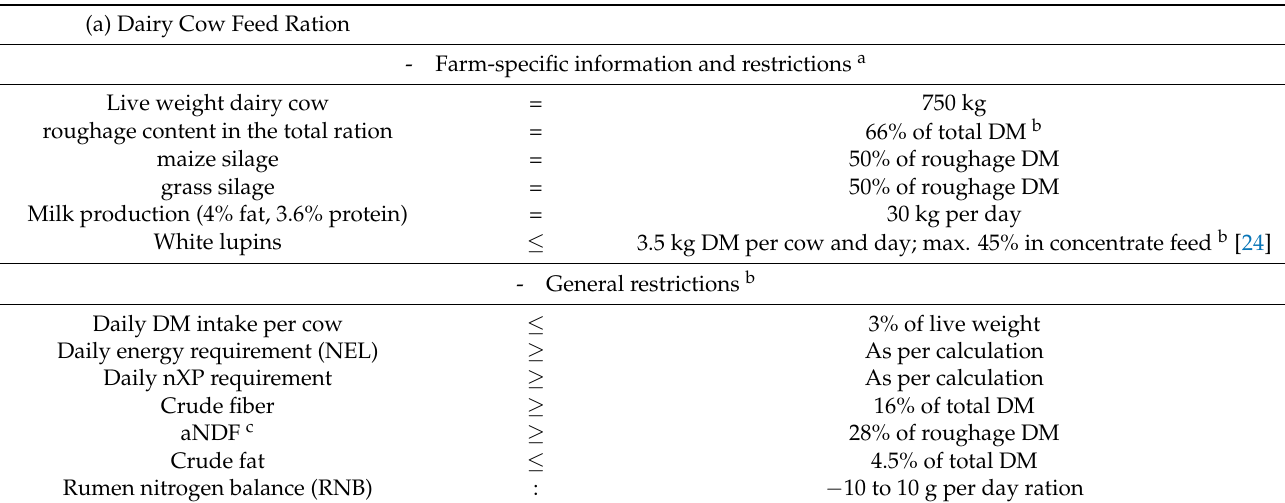
Table 2. Feeding